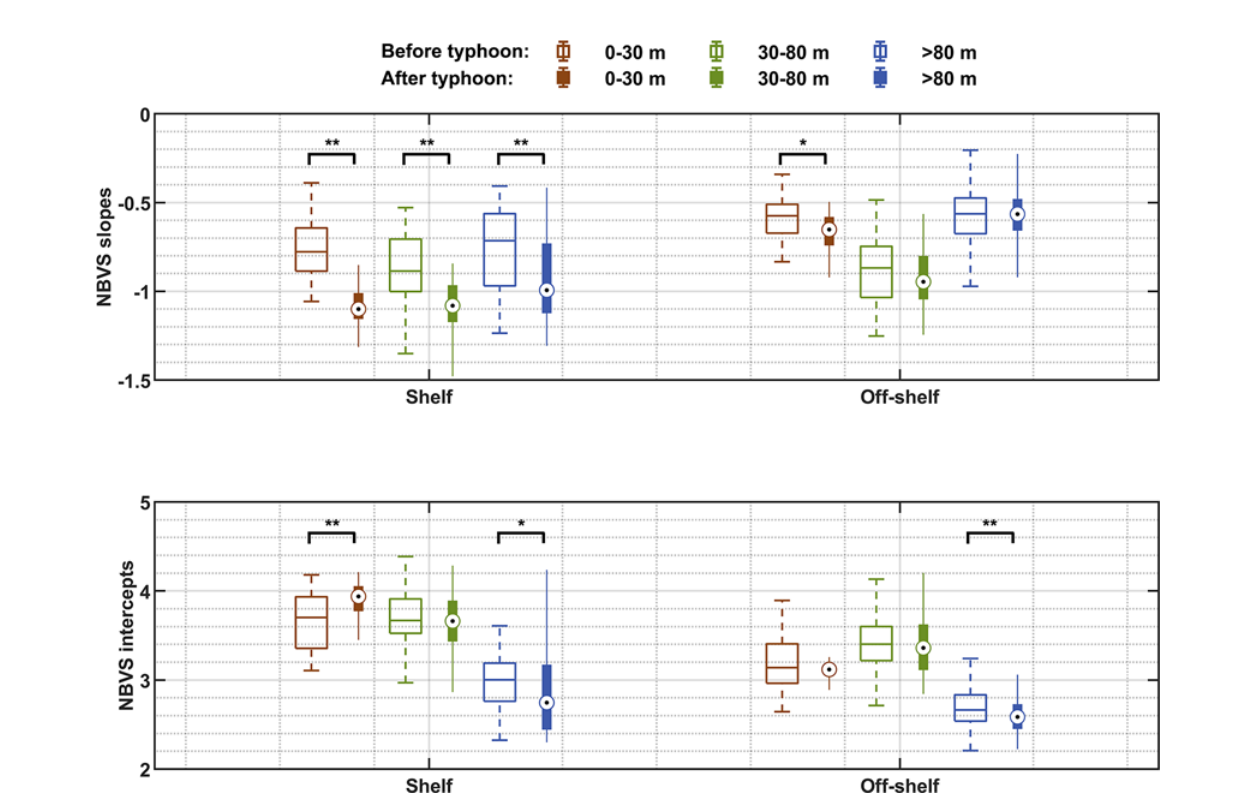
FIGURE 9 | The slopes (upper panel) and intercepts (lower panel) of each layer in the shelf and off-shelf regions before and after the typhoon. The hollow bars are the averages before the typhoon, the solid bars are the averages after the typhoon, and the short lines or circles in the boxes are the medians. Each data group before and after the typhoon was tested by the Mann – Whitney U test. The test results are marked above the short black lines. ** p < 0.01, * p <